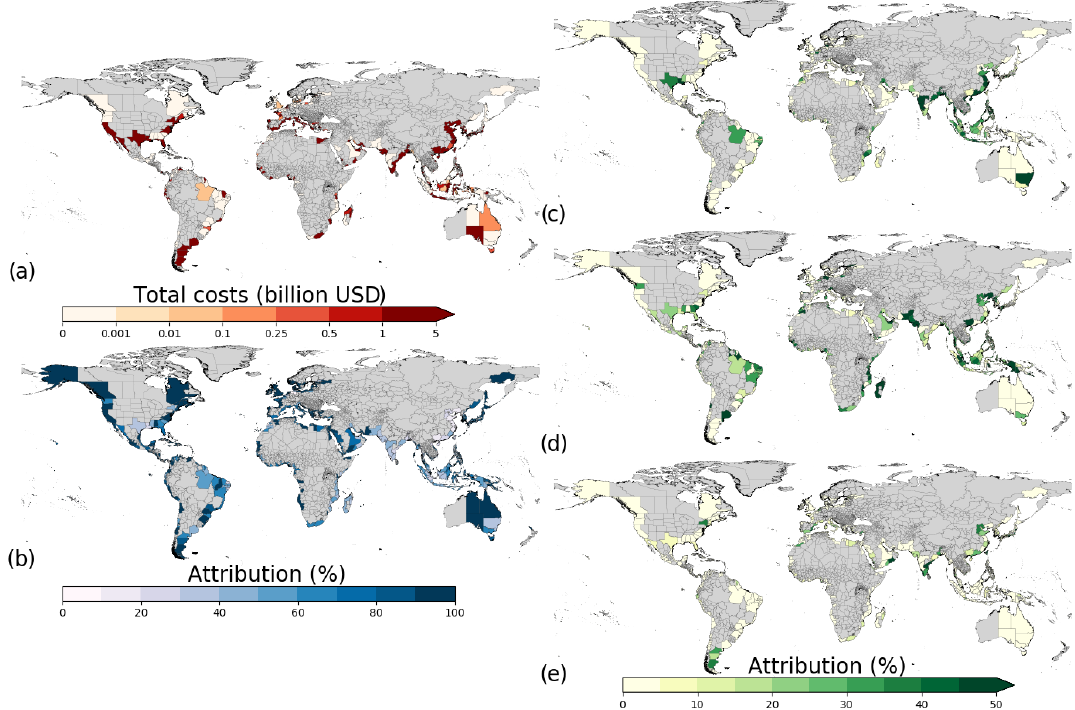
Figure 9. Attribution of costs overview for RCP4.5–SSP2, with (a) total costs, (b) attribution of sea-level rise (ATR SLR ), (c) attribution of current optimizing (ATR CUR ), (d) attribution of socioeconomic change (ATR SEC ), and (e) subsidence (ATR SUB ). Note that the attribution of SLR is on a different scale, and regions with no data are indicated in grey.